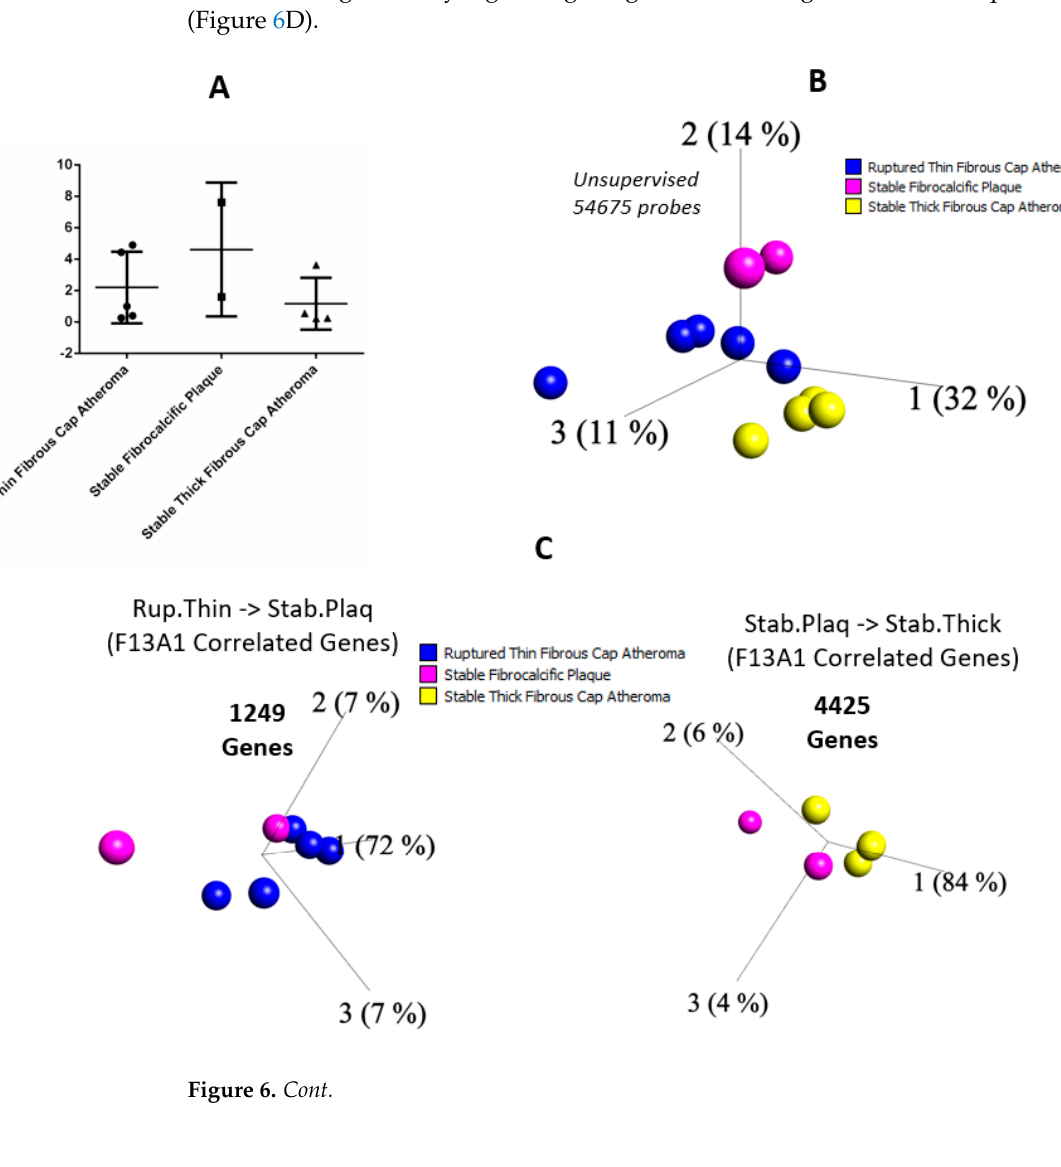
Figure 6. The expression analysis of plaque stability. ( A ) F13A1 expression in plaque stability. ( B ) 3D-PCA of plaque-stability-derived data points. Blue: Ruptured Thin Fibrous Cap Atheroma; yel- low: Stable Thick Fibrous Cap Atheroma; and dark pink: Stable Fibrocalcific Plaque. ( C ) 3D-PCA of significant F13A1-expression-correlated genes at p < 0.05; left: significantly correlated genes with F13A1 expression in Ruptured Thin Fibrous Cap Atheroma to Stable Fibrocalcific Plaque; and right: significantly correlated genes with F13A1 expression in Stable Fibrocalcific Plaque to Stable Thick Fibrous Cap Atheroma. ( D ) Significant upstream regulators of F13A1-expression-correlated genes in left: Ruptured Thin Fibrous Cap Atheroma to Stable Fibrocalcific Plaque; right: Stable Fibrocal- cific Plaque to Stable Thick Fibrous Cap Atheroma; orange: predicted overexpressed; blue: predicted under-expressed; red: overexpressed; and green: under-expressed in Ruptured Thin Fibrous Cap Atheroma compared to Stable Fibrocalcific Plaque or Stable Fibrocalcific Plaque compared to Stable Thick Fibrous Cap Atheroma .